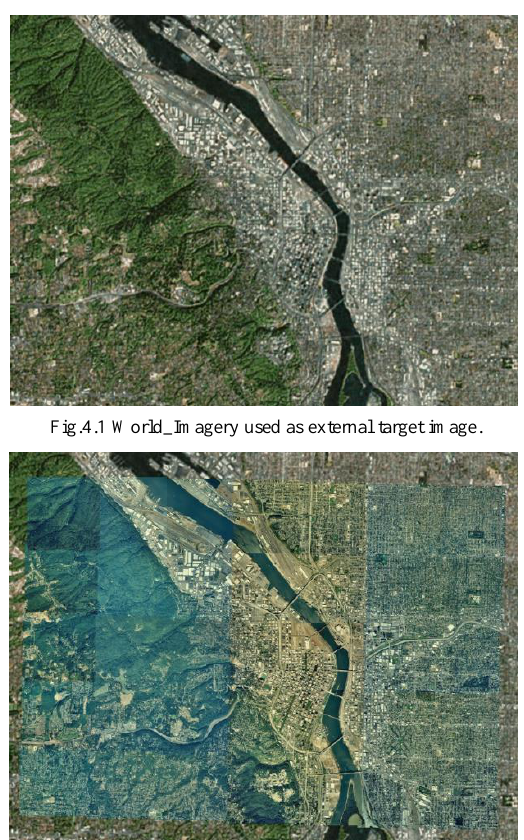
Fig.4.2 Original MD superimposed on the external target image.